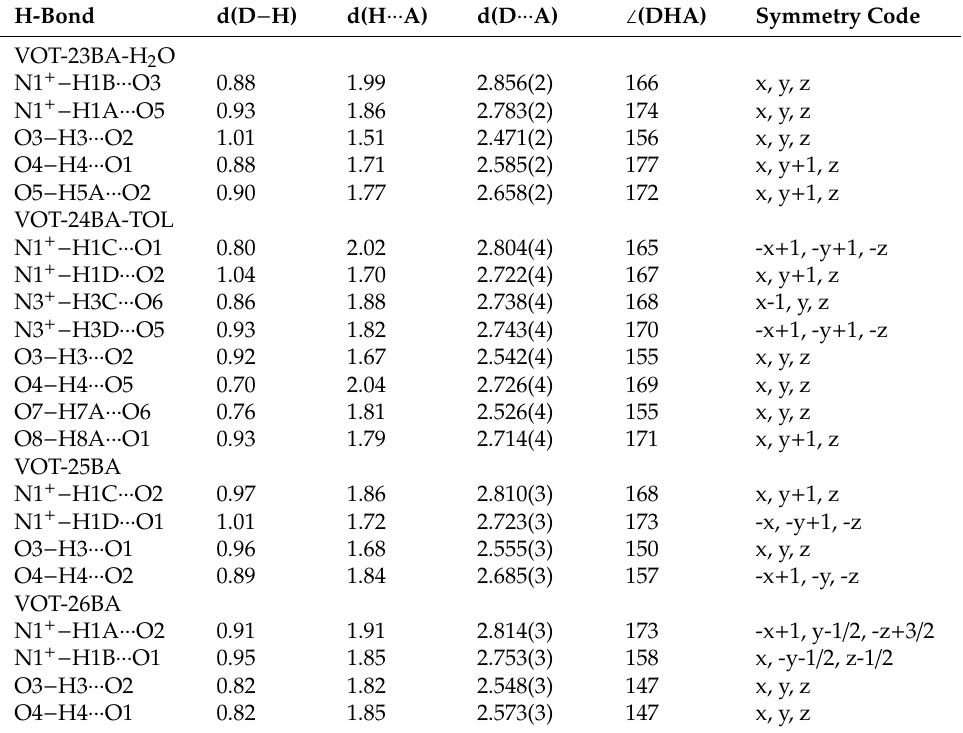
Table 2. Hydrogen bond distances (Å) and angles ( ◦ ) of vortioxetine and its dihydroxybenzoic acid salts.